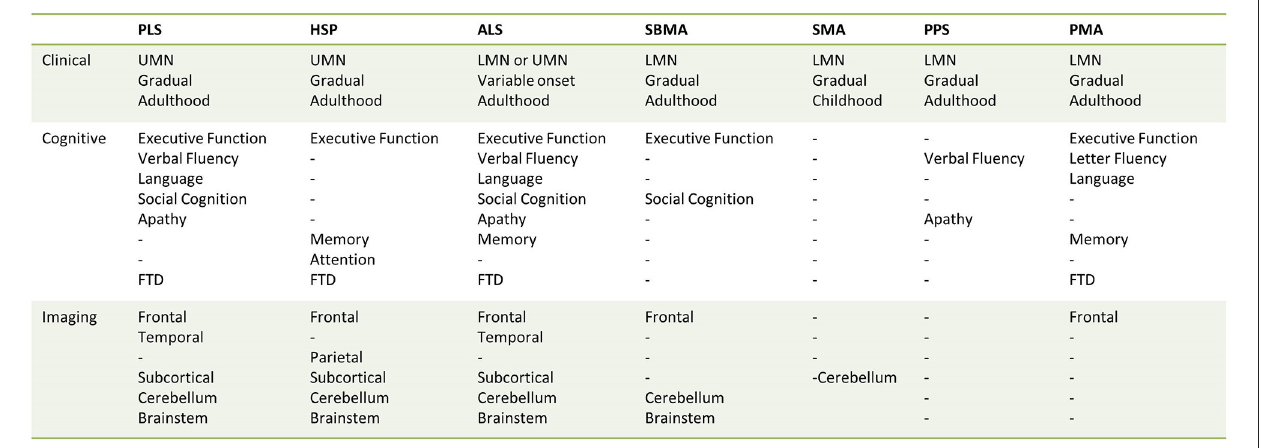
stimulation (280, 281). These methods are not only applicable to symptomatic patients but also to those in the pre-symptomatic stages of their disease. In ALS, genotype-specific radiological alterations have been detected in pre-symptomatic carriers of pathogenic mutations decades before the onset of clinical symptoms (282–284). Awareness of associated behavioral